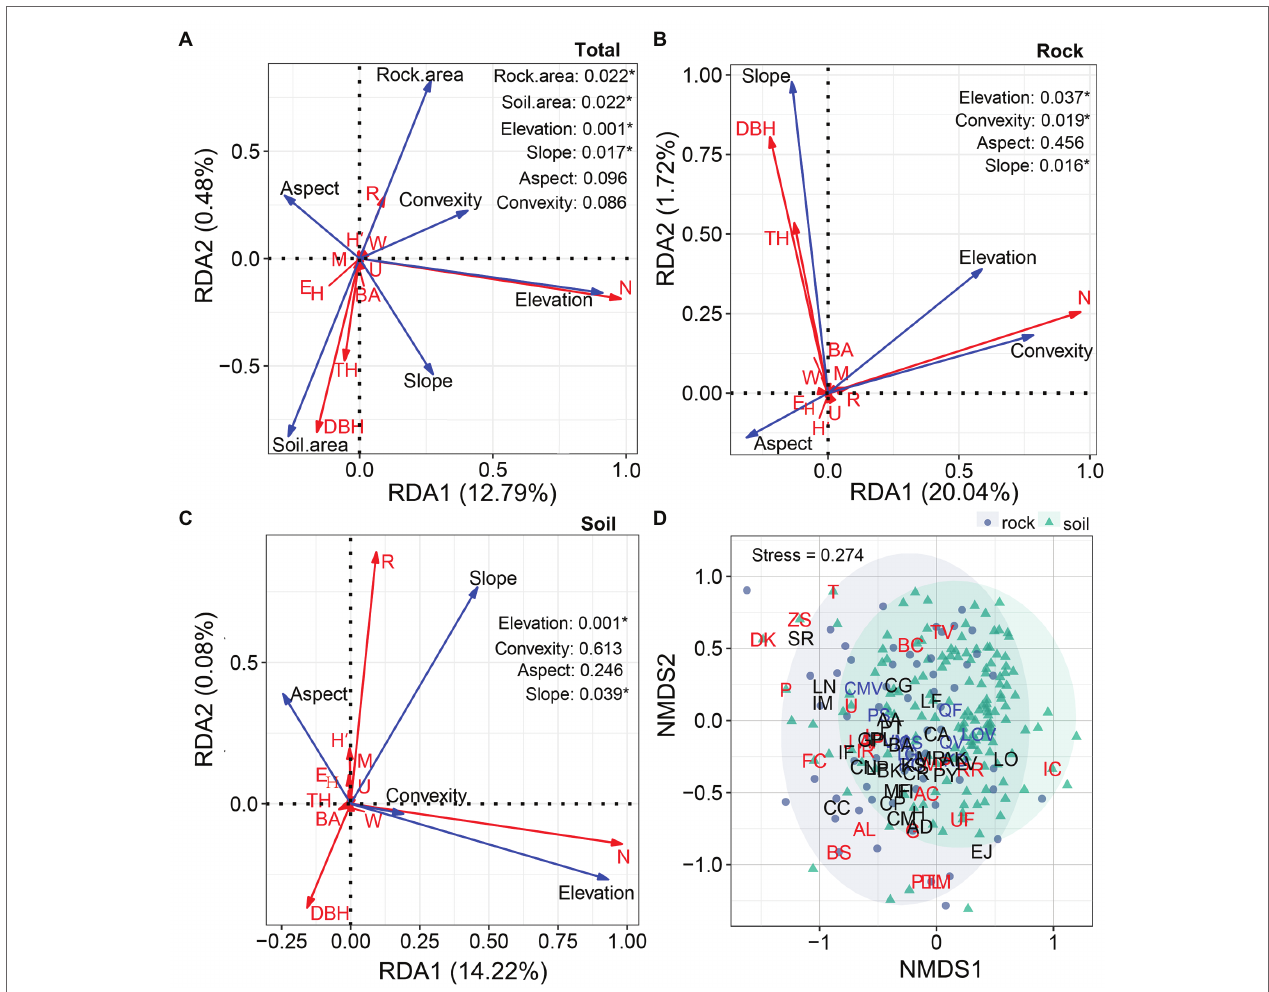
FIGURE 8 | Redundancy analysis ordinations illustrating the influences of environmental variables (area of soil and rock, elevation, convexity, aspect, and slope, represented by blue arrows) on diversity (richness (R), abundance (N), H ′ , E H , uniform angle index (W), mingling (M), and dominance (U), represented by red arrows) and tree size (TH, DBH, and BA, represented by red arrows; A–C) . Non-metric multidimensional scaling ordinations of compositional patterns in the rock and soil quadrats (D) . Blue letters represent the 10 most abundant species, red letters represent rare species ( N ≤ 1/ha; R = 22), and black letters represent other species (3 ≤ N < 50; R = 30). The solid gray circles represent rock quadrats, and the cyan triangles represent soil